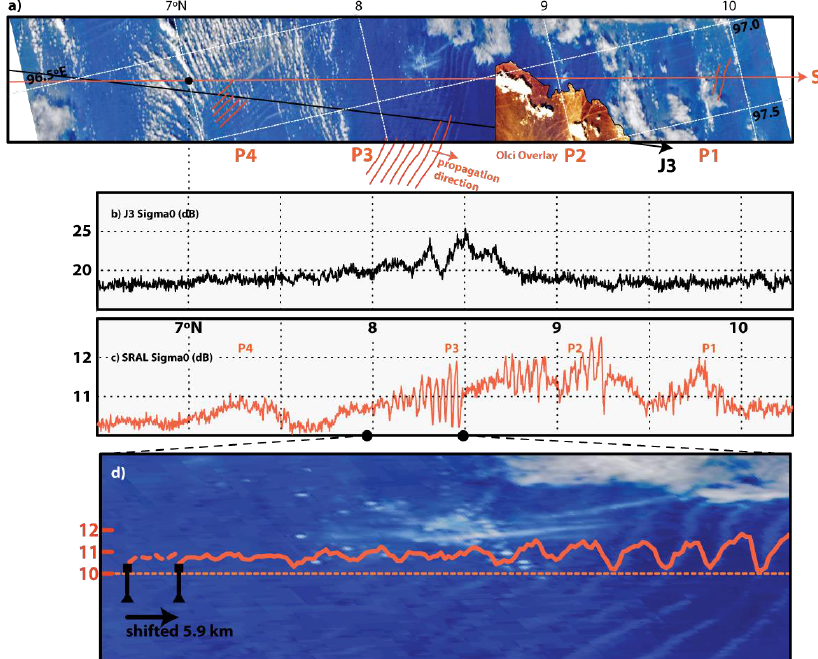
Figure 2. ( a ) Composite map of Sentinel-3A Ocean Land Colour Imager (OLCI) (partially shown in orange tones) with wave crests delineated as orange curves on top of a Terra Moderate Resolution Imaging Spectroradiometer (MODIS) acquisition (blue tones). The Sentinel-3A satellite track projected on the ground is marked with a red line while longitudes and latitudes are marked in white. The Jason-3 ground track is also shown in a black line. ( b ) Jason-3 along-track radar backscatter record for the Ku-band (20 Hz) in (dB) units (σ 0 ). ( c ) Along-track SRAL record in backscatter (dB) units (σ 0 ) for the Ku-band. The labels P1 to P4 indicate different ISW trains and latitudes are displayed on the top of the vertical grid. ( d ) Enlargement of image section in the latitude interval [8.0, 8.5]°N showing the surface manifestations of ISWs due to sunglint co-located with the SRAL backscatter record. Note that the backscatter record was displaced by 5.9 km to account for the internal wave propagation between the times of MODIS and Sentinel-3A acquisitions (see text for details).